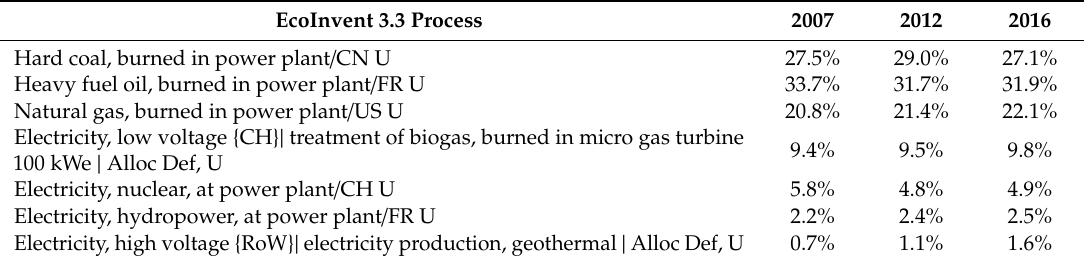
Table A2. World primary energy supply modeling with EcoInvent data [70] in accordance with IEA [1]